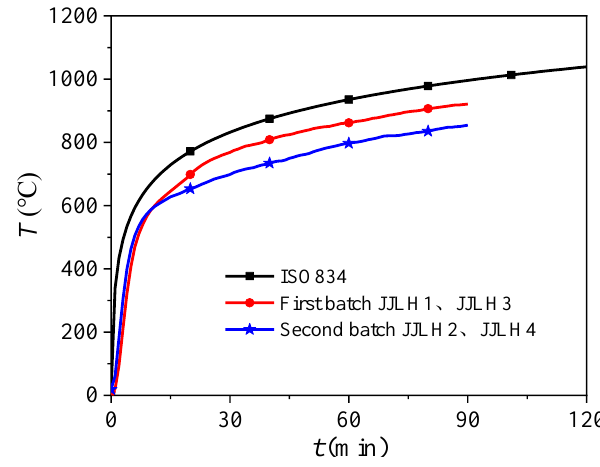
Figure 7. Measured temperature curves in the furnace.